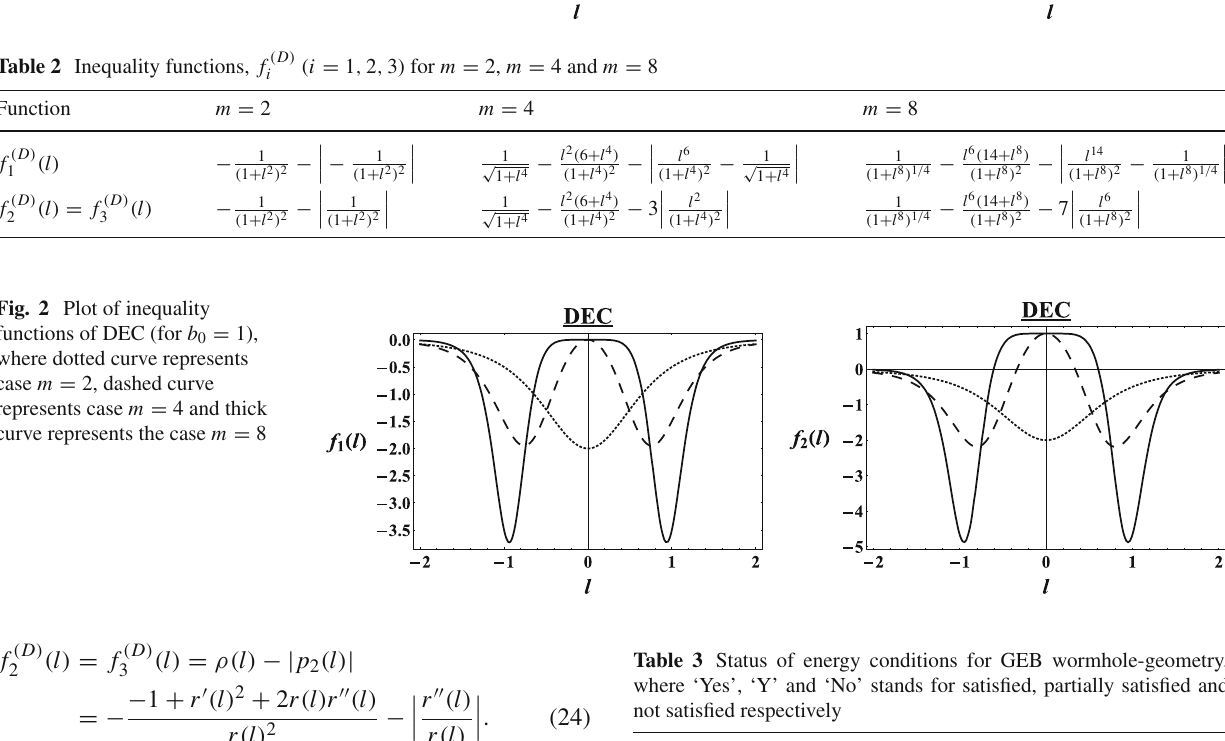
Fig. 1 Plot of inequality ( W ) ( W ) functions f and f (with 0 2 b 0 = 1), where dotted curve represents case m = 2, dashed curve represents case m = 4 and thick curve represents case m = 8